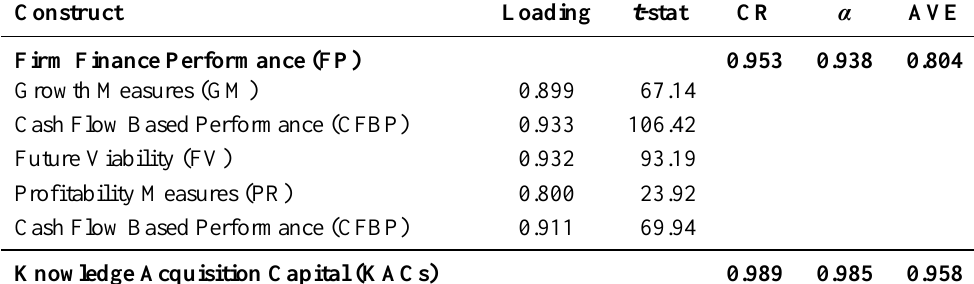
Table 5: Reliability and Validity of Third-Order Constructs Construct